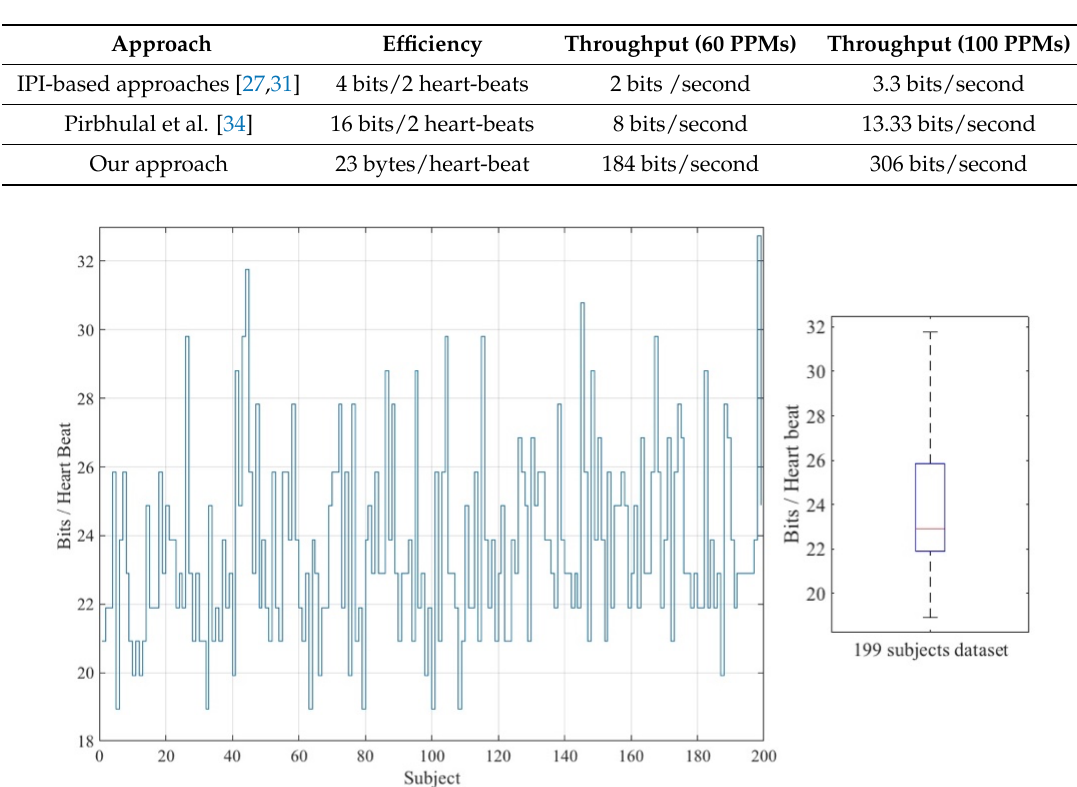
Table 6. Performance analysis.